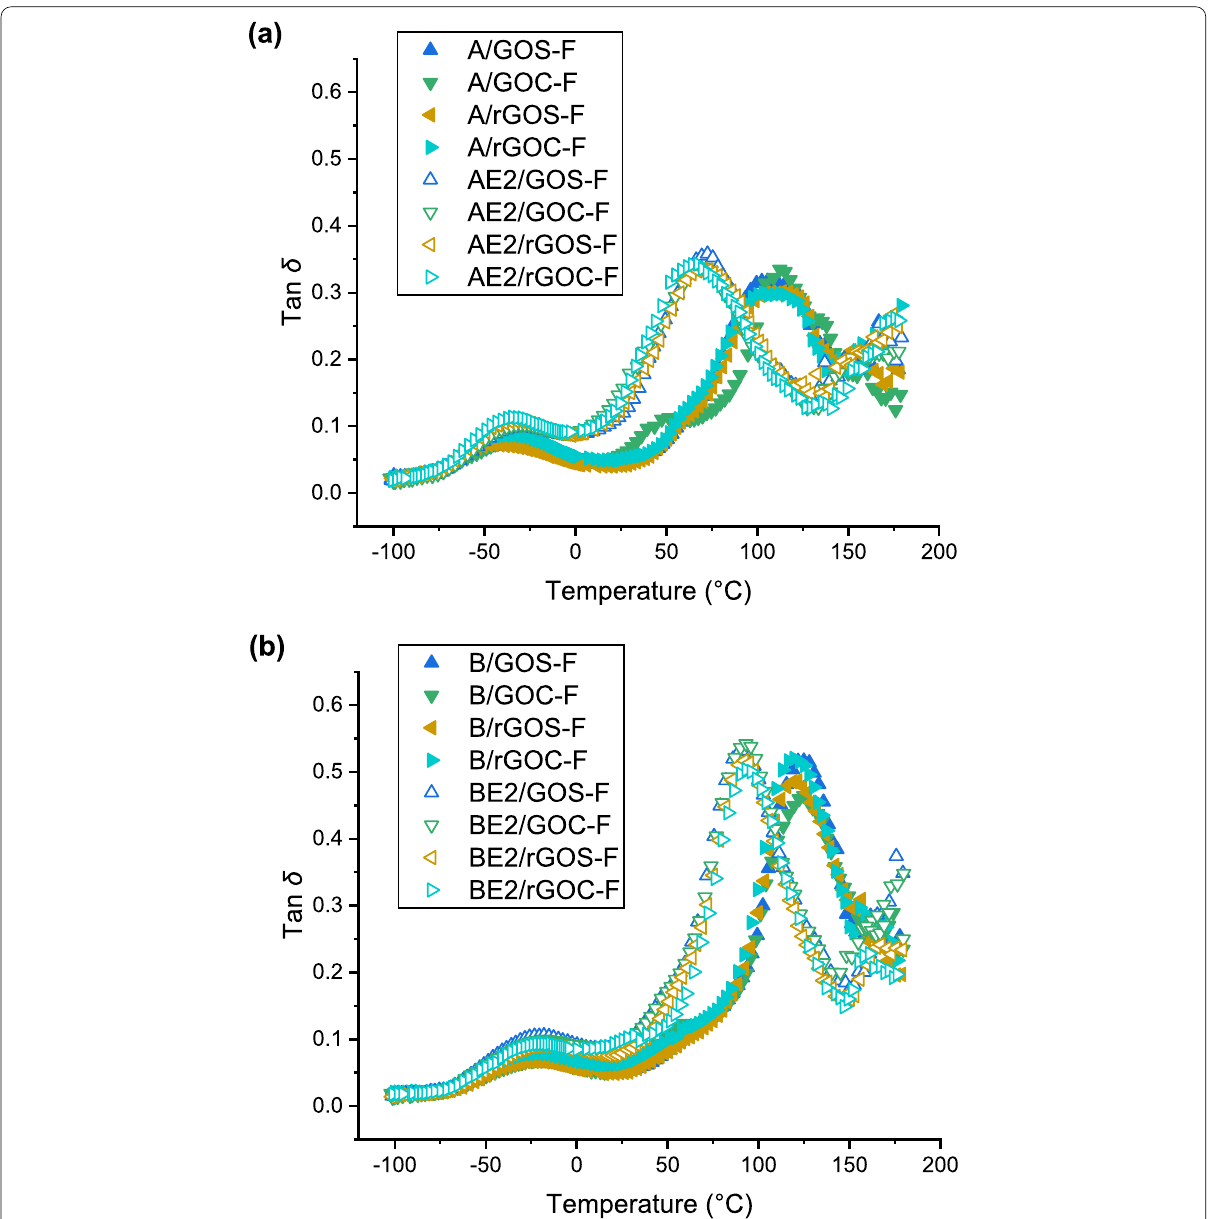
Fig. 5 Dynamic mechanical thermal analysis (DMTA) results (loss tangent (tan δ ) vs. temperature) for the different a chitosan and b chitosan/ carboxymethyl cellulose (CMC)-based nanocomposite